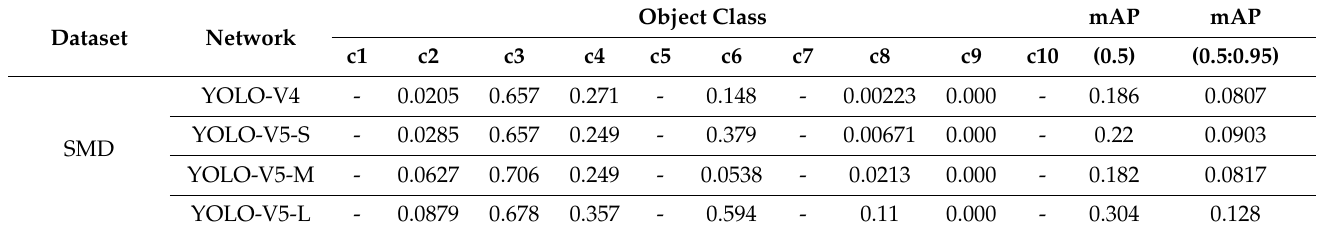
Table 5. Detection-then-classification results for the SMD dataset: c1: Boat, c2: Speed Boat, c3: Vessel/ship, c4: Ferry, c5: Kayak, c6: Buoy, c7: Sail Boat, c8: Others, c9: Flying bird and plane, c10: Swimming